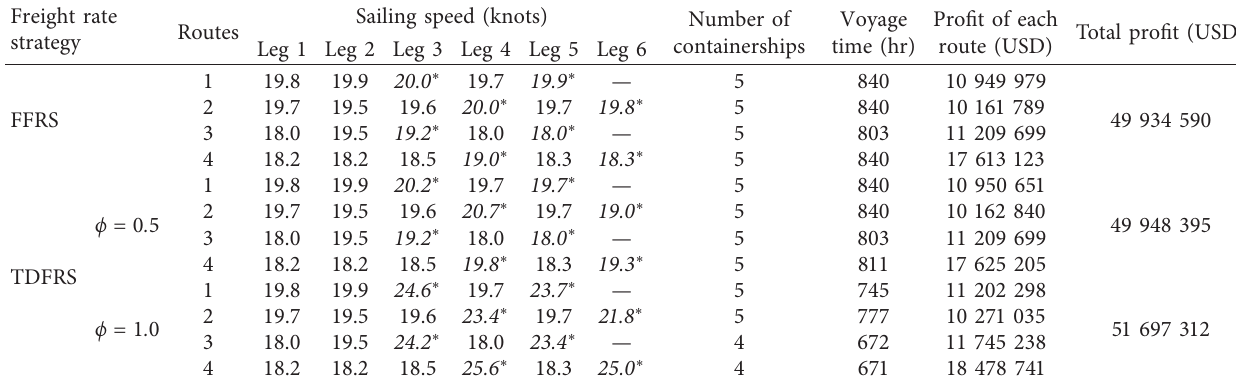
Table 5: Results obtained by the proposed optimization model under FFRS and